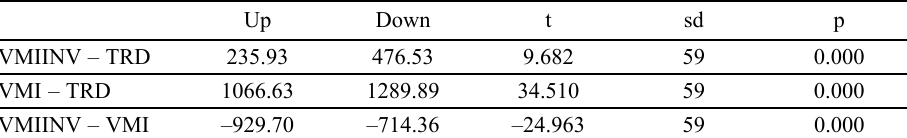
Table 7. Paired comparisons for total retailers’ profit